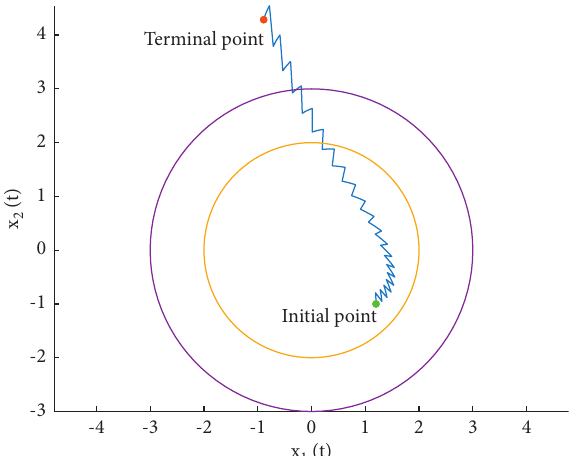
Figure 2: Phase portrait of the uncontrolled impulsive linear system equation (22) with 0 . 1s equidistant impulsive